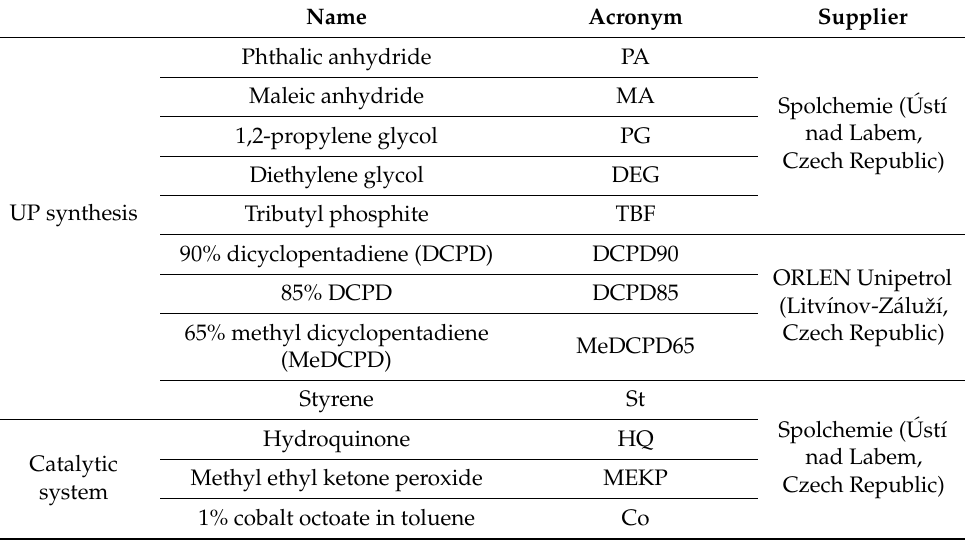
Table 1. Raw materials for unsaturated polyester (UP) synthesis and